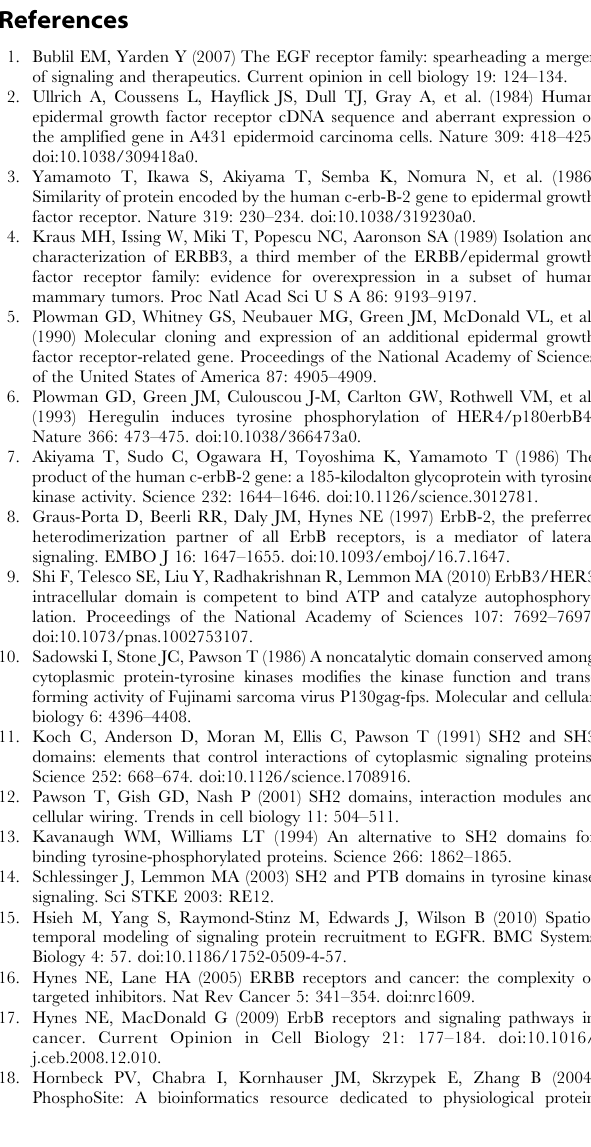
Table S13 Sum of binding free energies (in kcal/mole) of SH2 domains in ErbB receptors. Table S14 Significant enrichment or depletion of bind- ing sites on each ErbB receptor for SH2 domains and gene ontology groups (permutation P , 0.05). Table S15 Molecular function classes of SH2 domains. (XLSX) Table S16 Average recruitment potential for each gene ontological class as a function of relative binding free energy (in kcal/mole). Table S17 Peptides synthesized for in-house protein